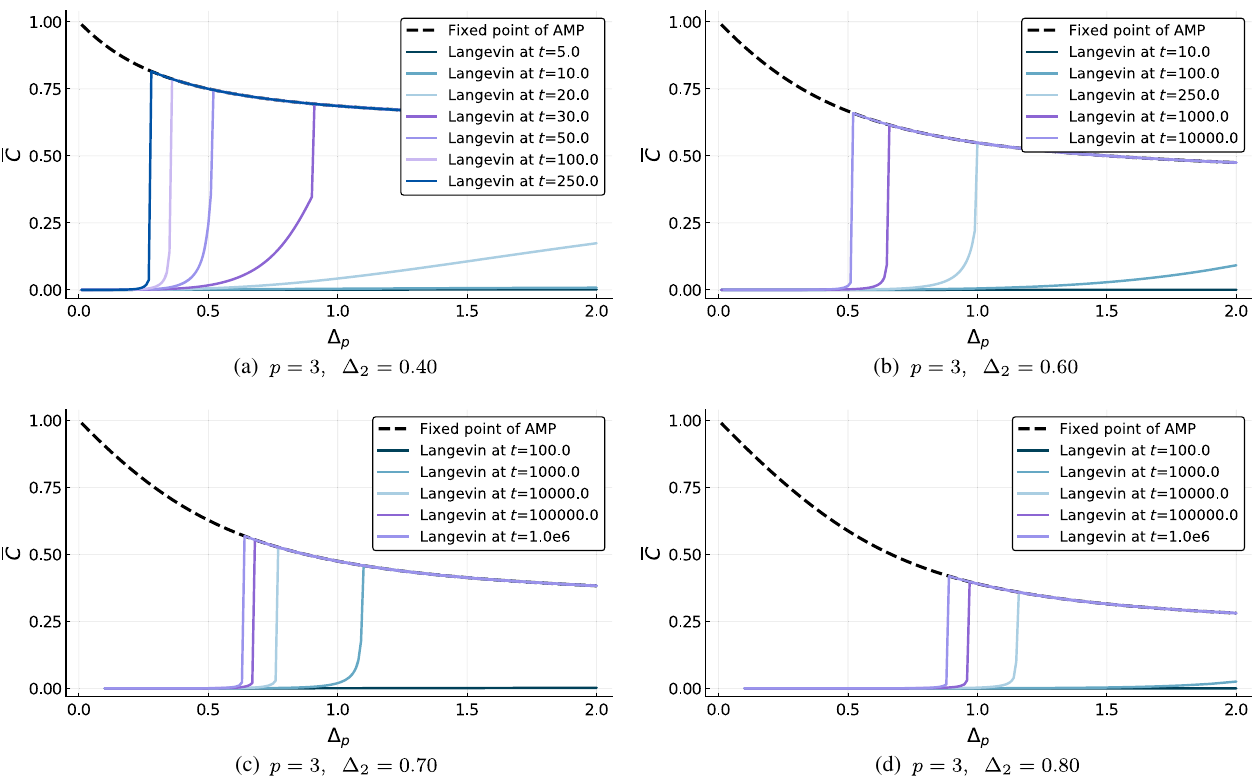
FIG. 13. Correlation with the signal of AMP (dotted lines) and Langevin (solid lines) at the k th iteration and t time, respectively, starting in both cases with an initial overlap of 10 − 4 . The black dashed line is the asymptotic value predicted with AMP. In the easy region, provided there is enough running time, Langevin dynamics finds the same alignment as AMP. The figures show qualitatively the same behavior for different values of Δ 2